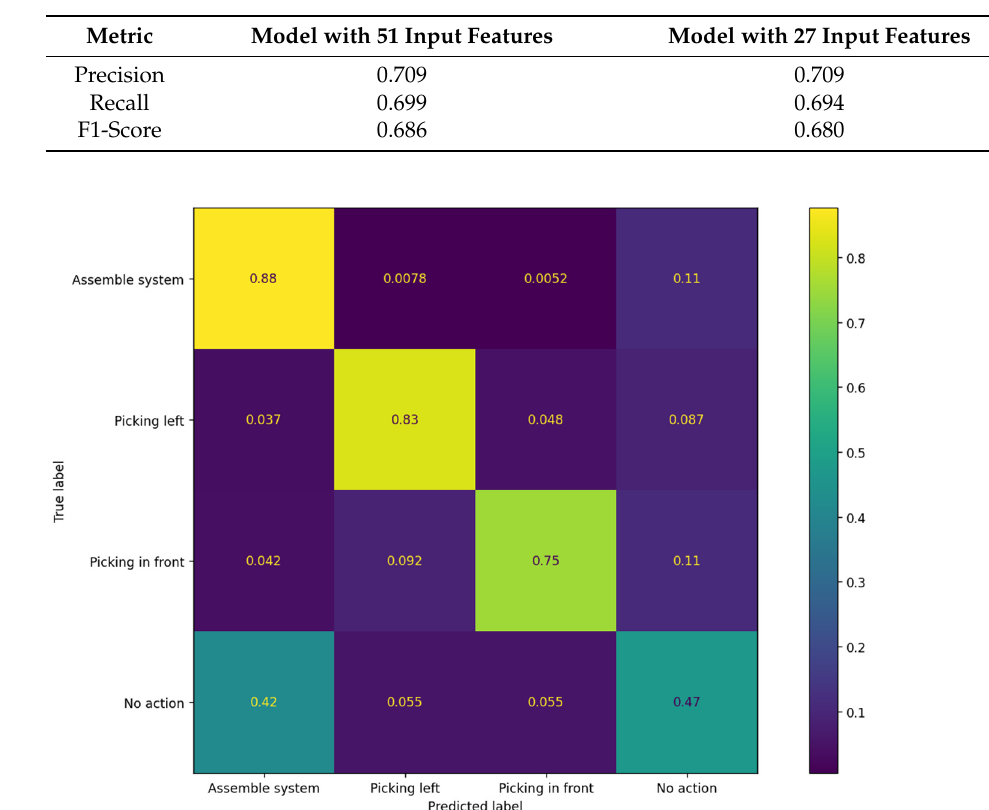
Table 3. Precision, recall, and F1-score for the trained models.